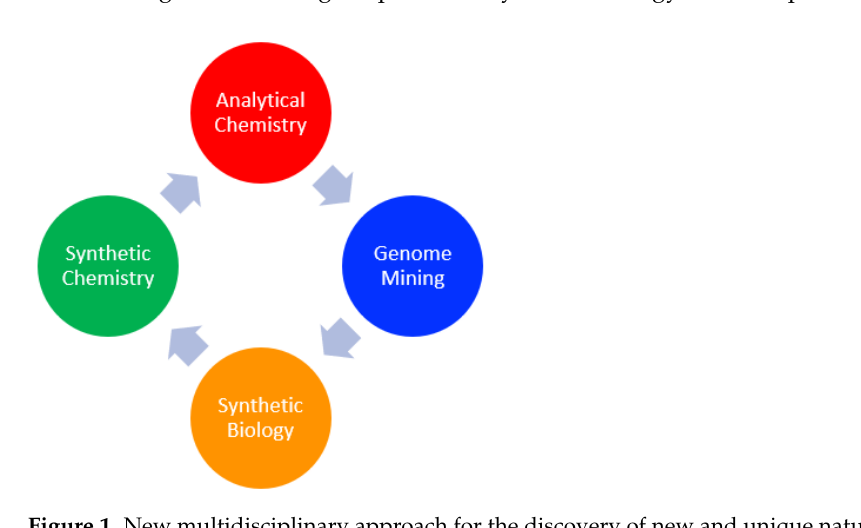
Figure 1. New multidisciplinary approach for the discovery of new and unique natural products.